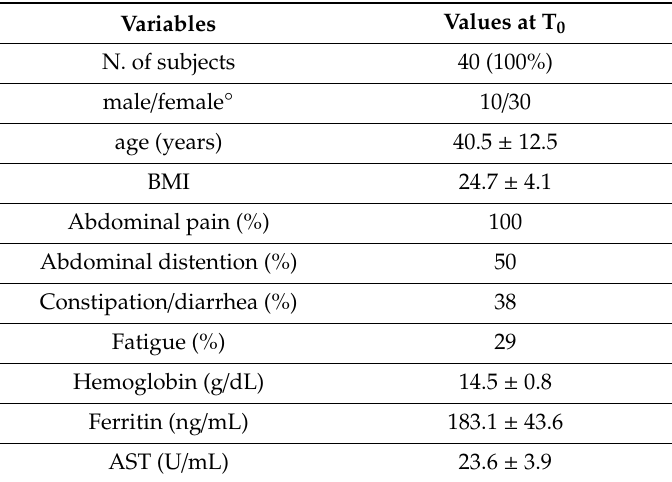
Table 1. Demographic, clinical and biochemical characteristics of patients who completed phase 1 (T 0 –T 1 ) of the study.